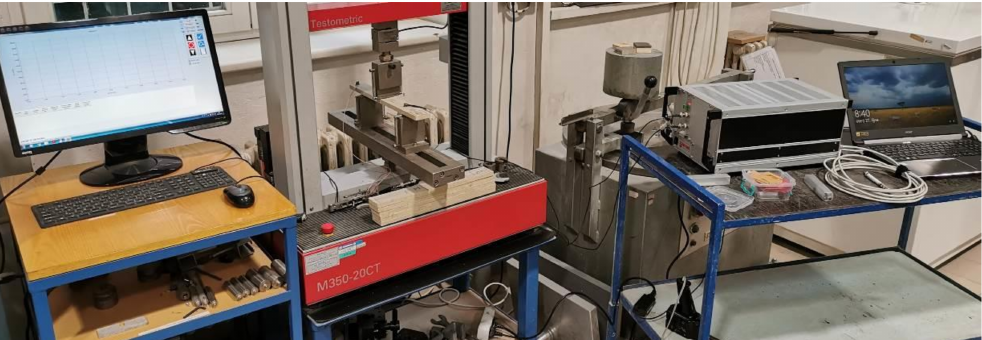
Figure 8. The scheme of arrangement for establishing bending strength and elasticity modulus with continual monitoring and recording of defects using acoustic emission; left-to-right: the press including computer technology, the testing specimen in the press with an attached exciter and acoustic emission sensor, the device for the processing of acoustic emission signal, including computer technology.